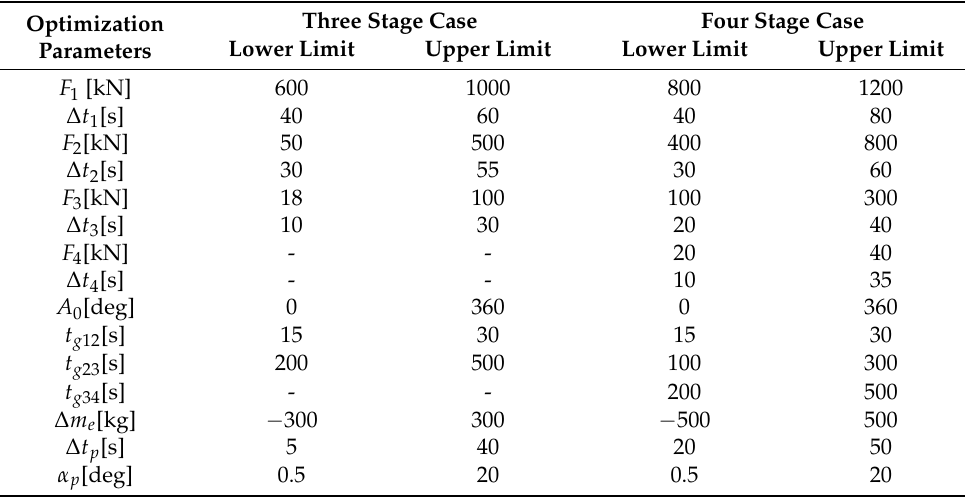
Table 2. Upper and lower limits of optimal design